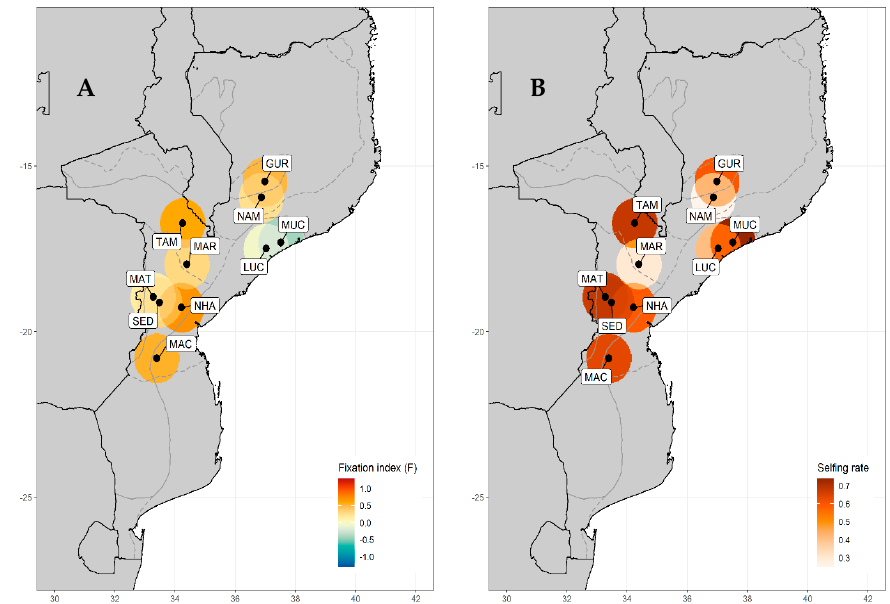
Figure 4. Map of the fixation index ( A ) and selfing rate ( B ) in 30 s (1 km) grid cells applying a 1-degree circular neighborhood. Dashed lines indicate the borders of agro-ecological zones